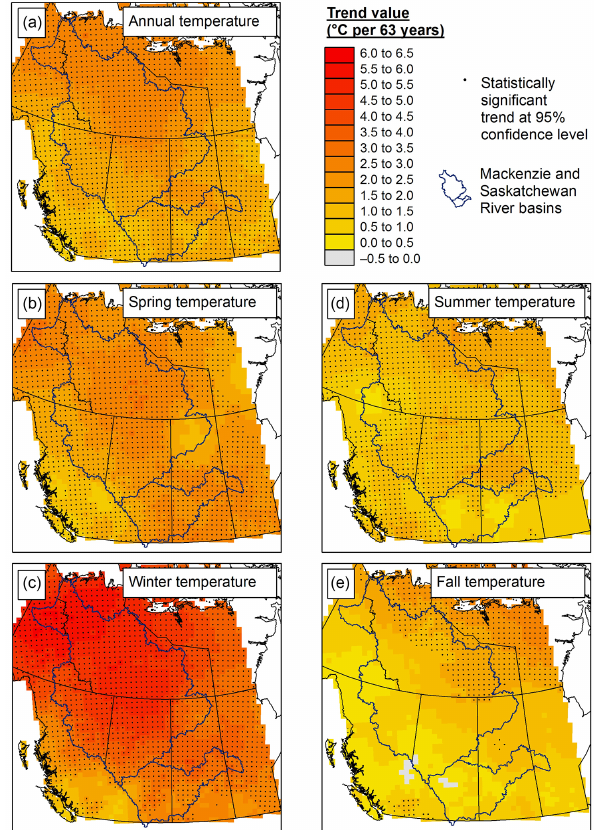
Figure 3. Spatial patterns of trends ( ◦ C per 63 years) in annual and seasonal average air temperatures over the period 1950–2012 across western Canada, based on analysis of CANGRD temperature